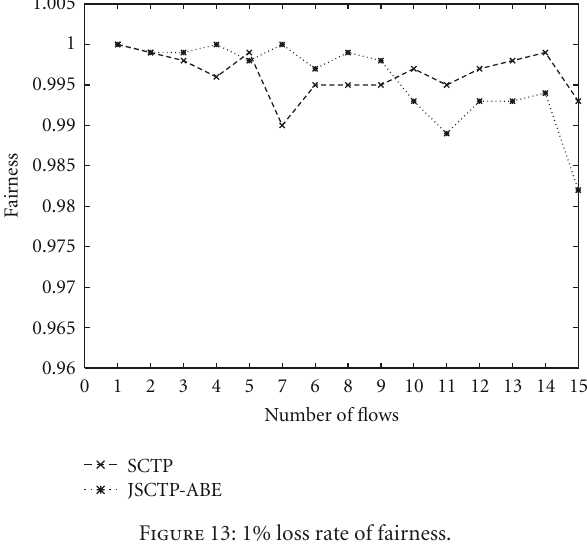
Figure 13: 1% loss rate of fairness.